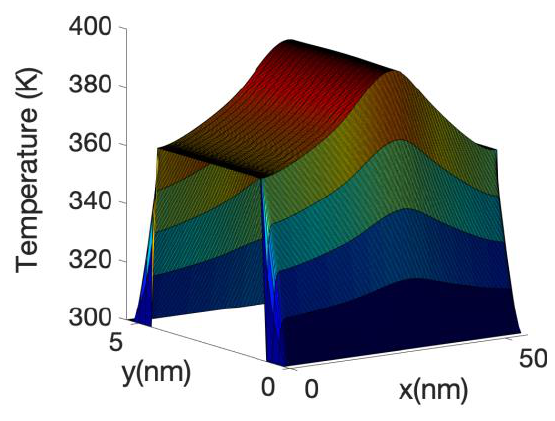
Figure 16. Lattice temperature profile at Vg = 0.7 V, hot electrons and self-heating.